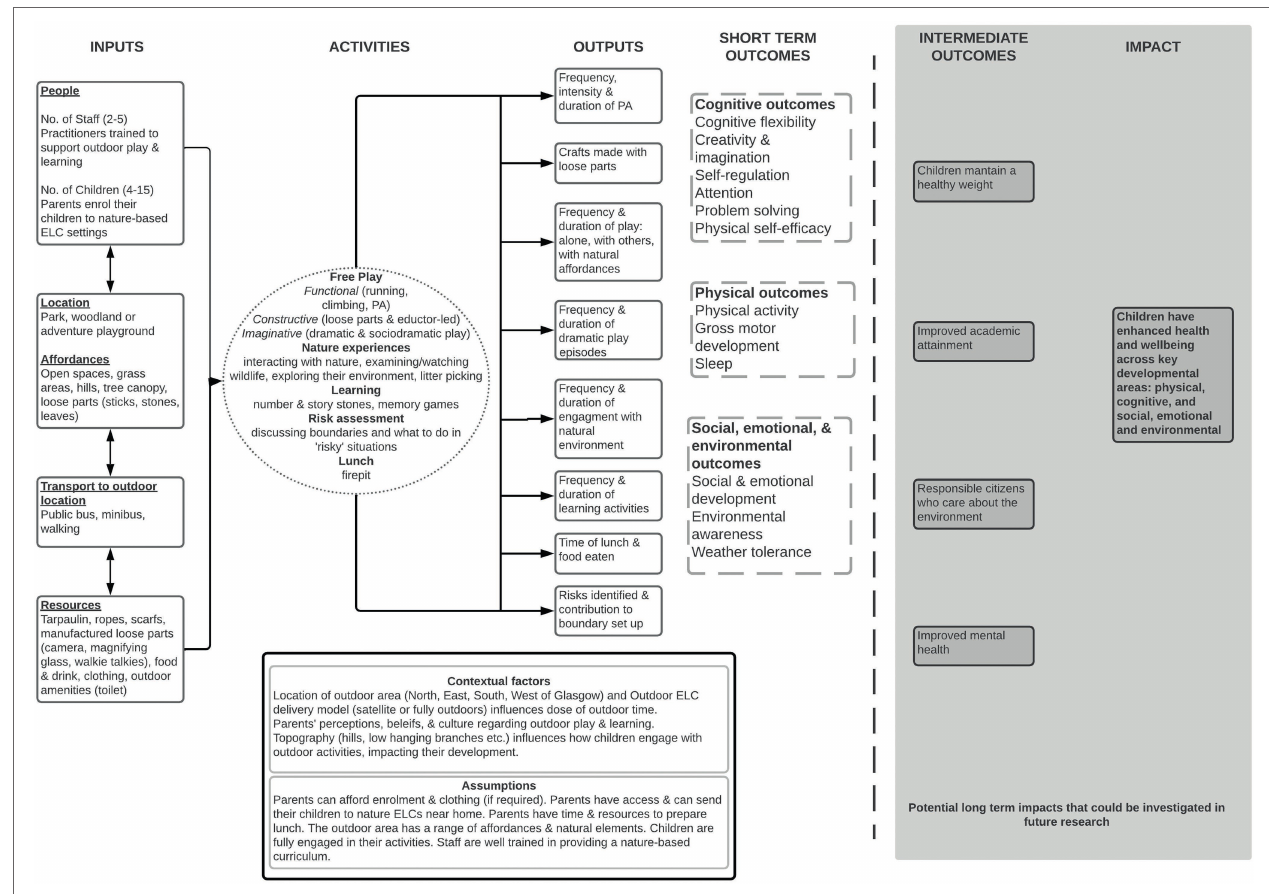
FIGURE 1 | Logic model of a nature-based ELC program in a Scottish urban setting. The figure outlines the inputs required for the activities to take place. The activities produce quantifiable outputs which lead to the measurable short-term outcomes based on the data analyzed in the present study. The outputs are suggestions by the authors based on the evidence demonstrated in this paper. The greyed area show possible intermediate outcomes and long-term impact of the program, however, longitudinal research is required to support these